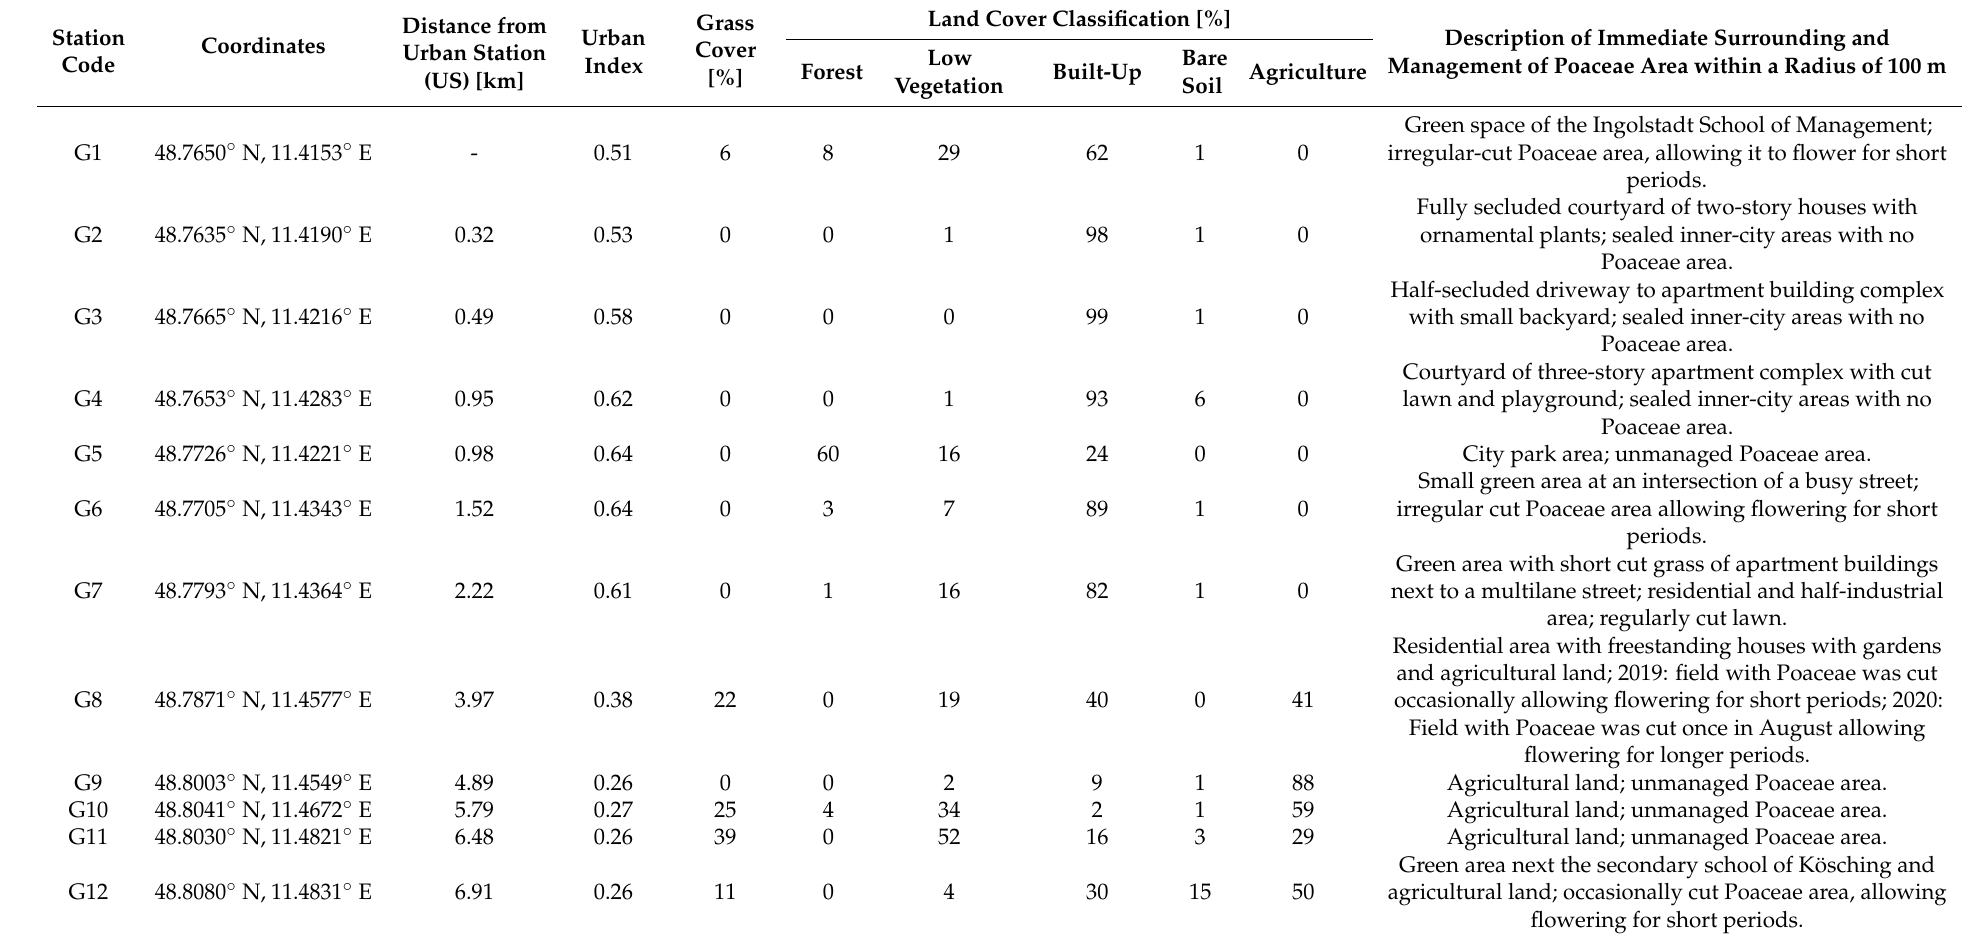
Table 1. Sampling locations and surroundings of gravimetric pollen traps. Grass cover [46] and land cover [45] within 100 m of the traps (see methodology section for calculation). Land cover class “water” is not listed as its values equalled 0 for all sampling locations. Station codes G1 to G12 (G = gravimetric) ascending with distance from the urban station